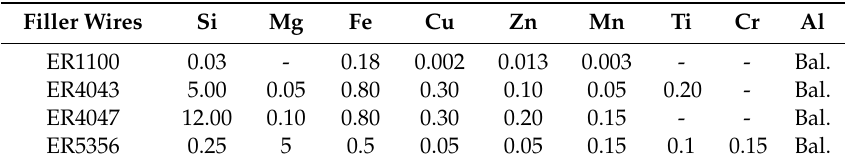
Table 1. Chemical composition of filler wires (mass fraction, %).